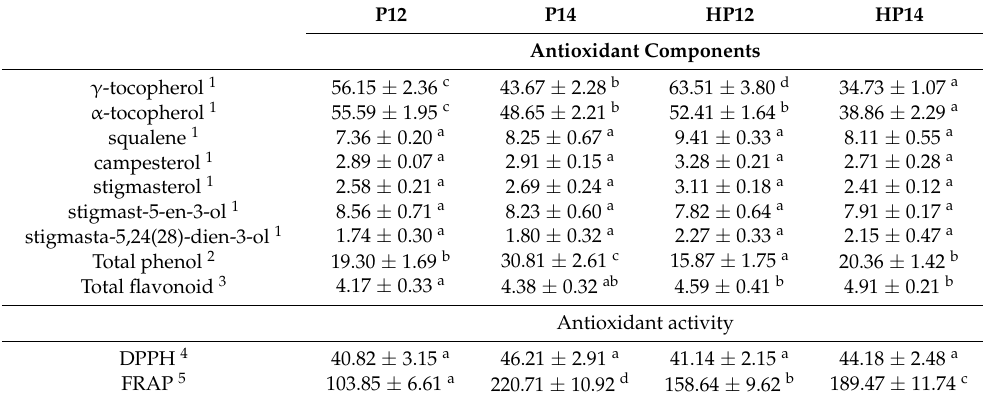
Table 2. The antioxidant composition and antioxidant activity for P12, P14, HP12, and